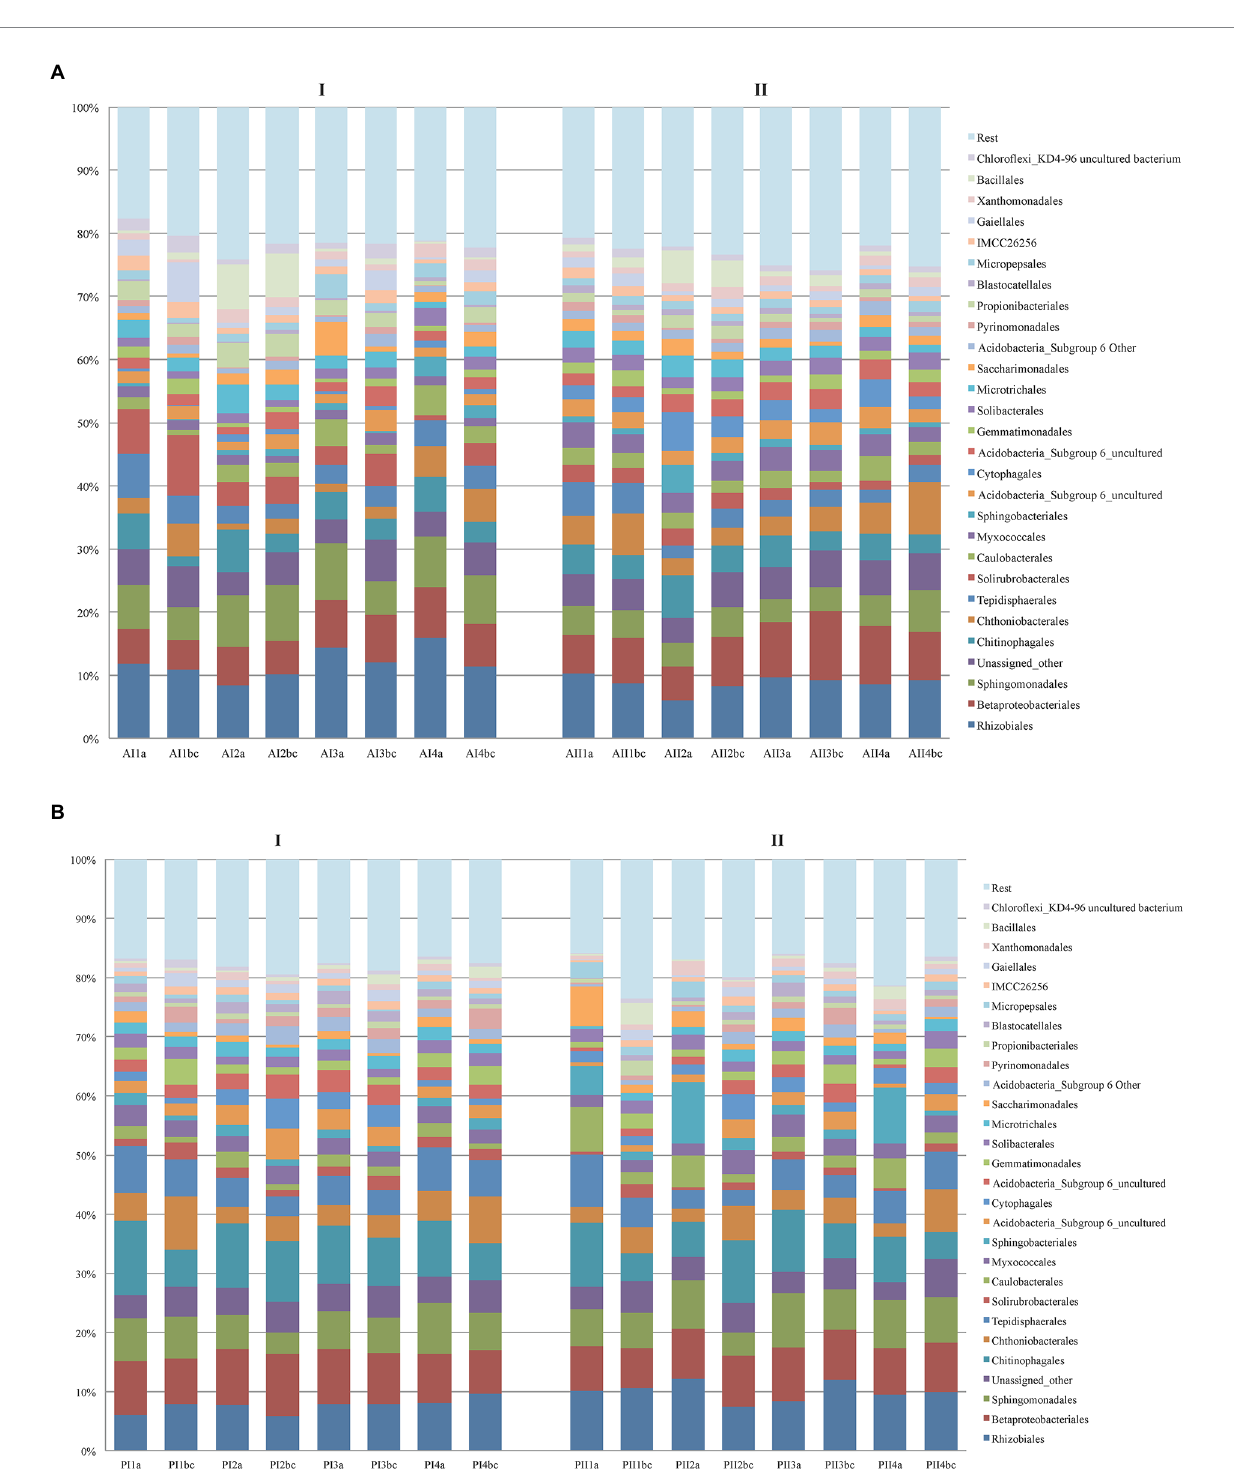
FIGURE 2 Distribution of the most abundant orders of Bacteria per soil depth (a,b,c), sampling plot (1,2,3,4) and season (I = winter, II = summer) in Parnitha (A) and Andros (B)